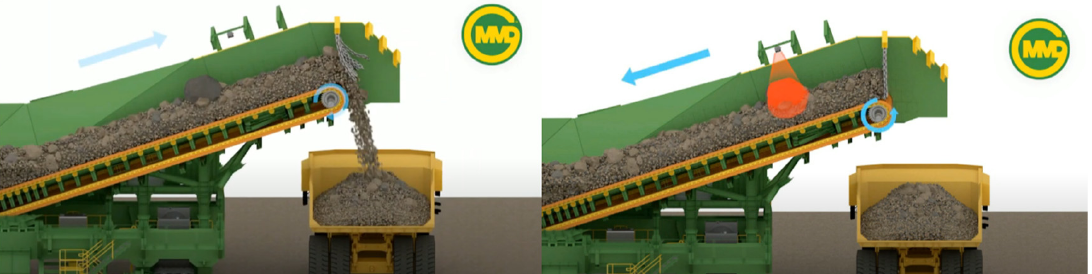
Figure 8. Presence of a large rock on the conveyor belt [23].